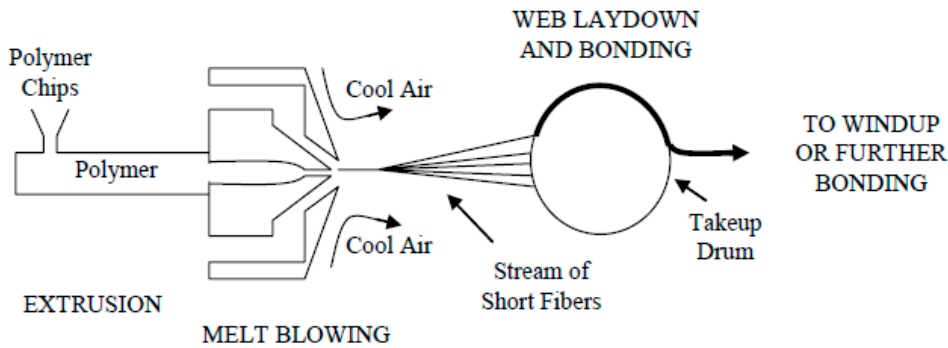
Figure 3. Schematic of the melt blowing process [35].